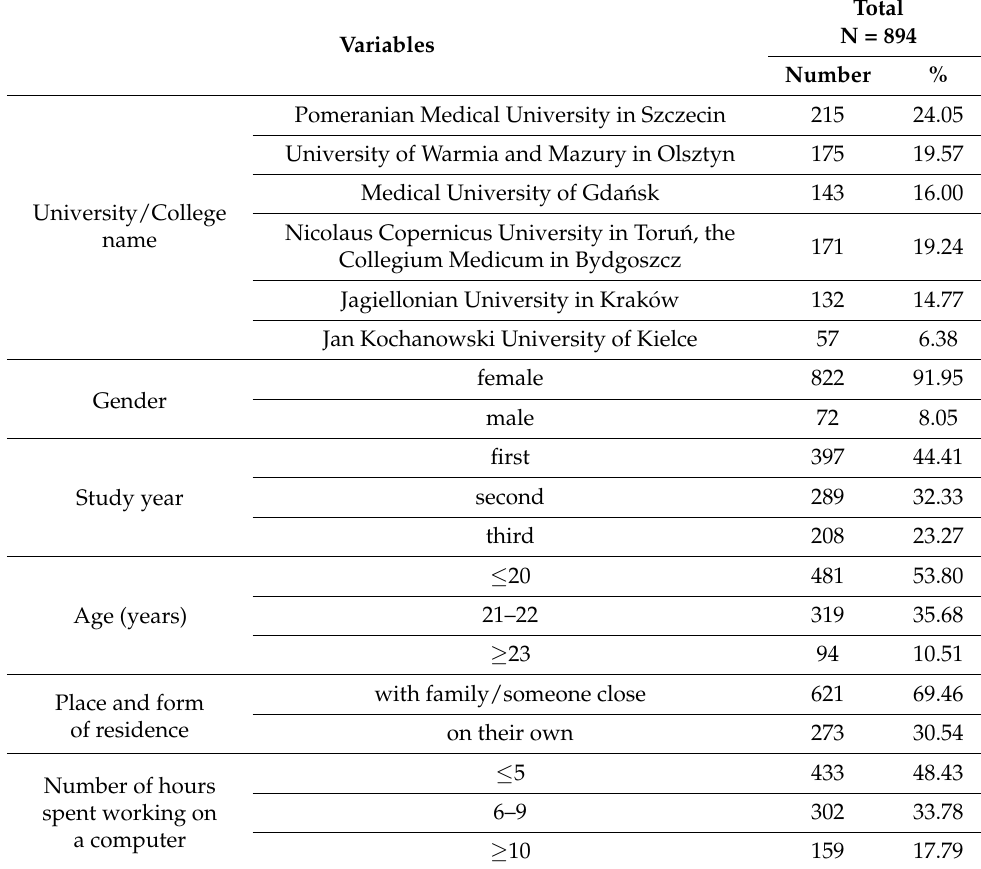
Table 1. Sociodemographic characteristics of the study group.